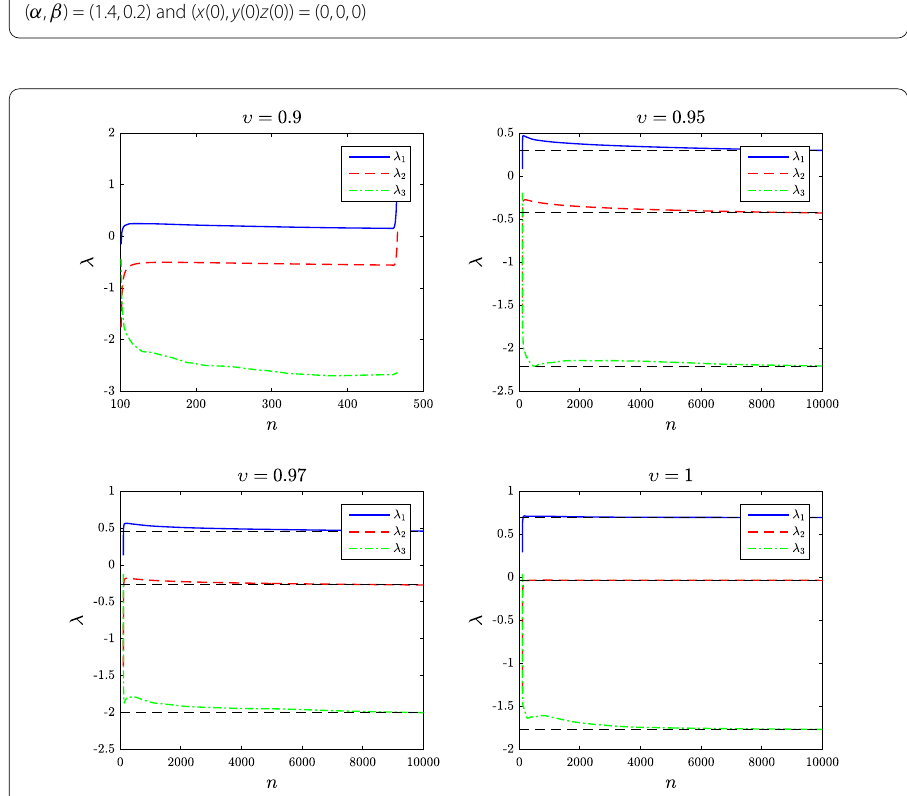
Figure 6 Estimated Lyapunov exponents of the fractional Stefanski map for ( α , β ) = (1.4,0.2), ( x (0), y (0) z (0)) = (0,0,0), and different fractional